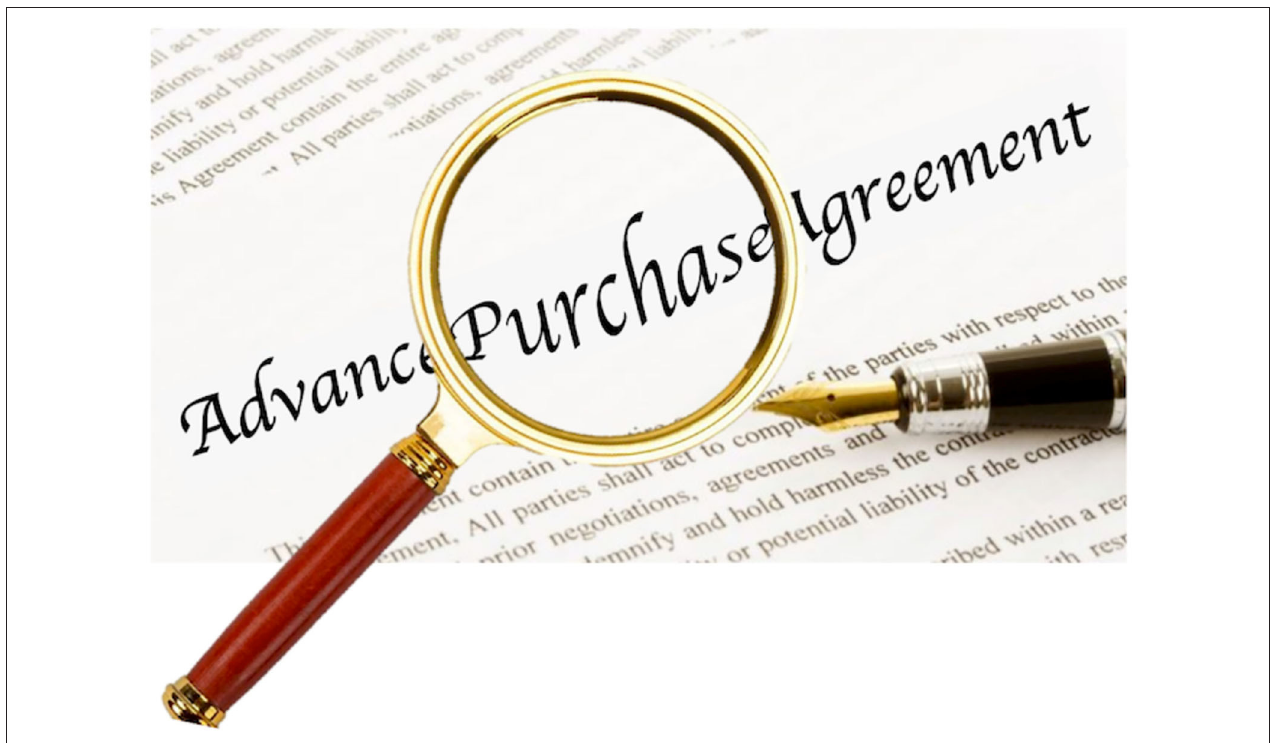
FIGURE 1 | Transparency in the negotiations for Advance Purchase Agreements (APAs) on COVID-19 vaccines. The EU is coordinating a joint effort to secure the acquisition of a sufficient quantity of COVID-19 vaccines in the EU through Advance Purchase Agreements (APAs) with vaccine producers, but transparency in negotiations is lacking, and sensitive business information remains confidential between the signatories of the